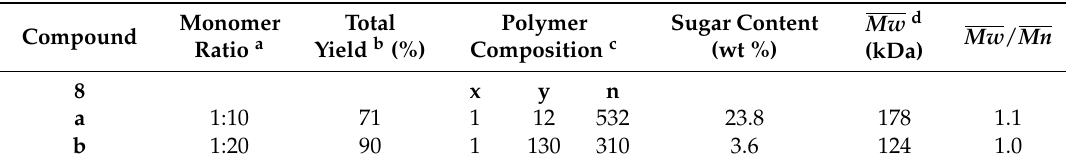
Table 1. Polymerizations of carbohydrate monomer with acrylamide.